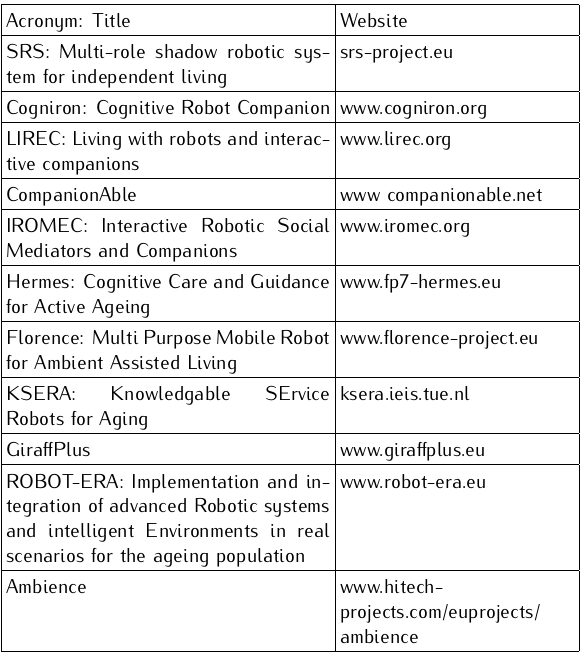
Table 1. Some of the existing and previously funded projects in this